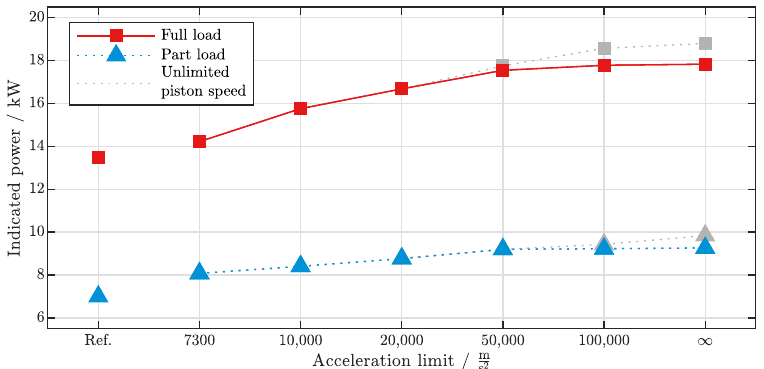
Figure 9. Evolution of the indicated power output of the cylinder for full and part load operation as a function of the maximum piston acceleration limit.